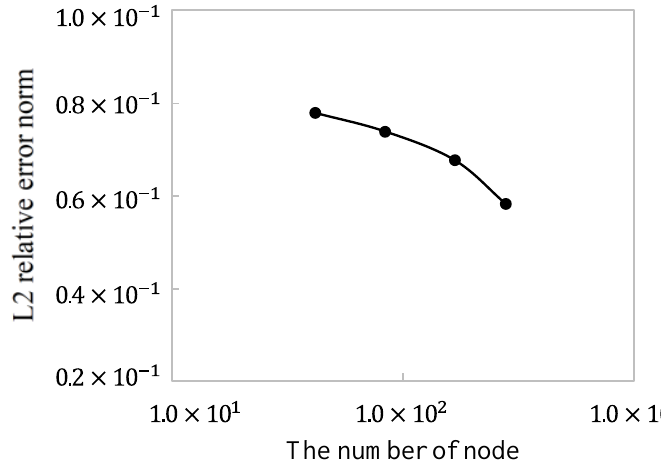
Figure 17. Convergence study of the synthetic structural analysis using the L 2 relative error norm.